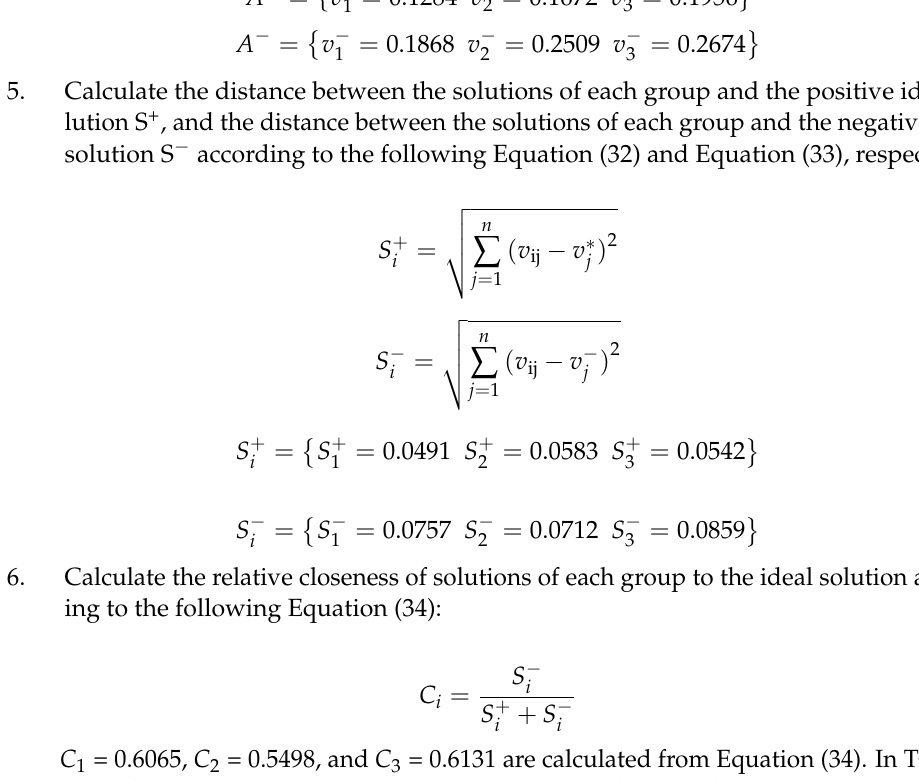
4. Find the positive ideal solution and negative ideal solution: Assuming that the best fitness values F min respectively, and the worst fitness values F max respectively, the positive ideal solution (A + ) and negative ideal solution (A − ) are obtained as follows: